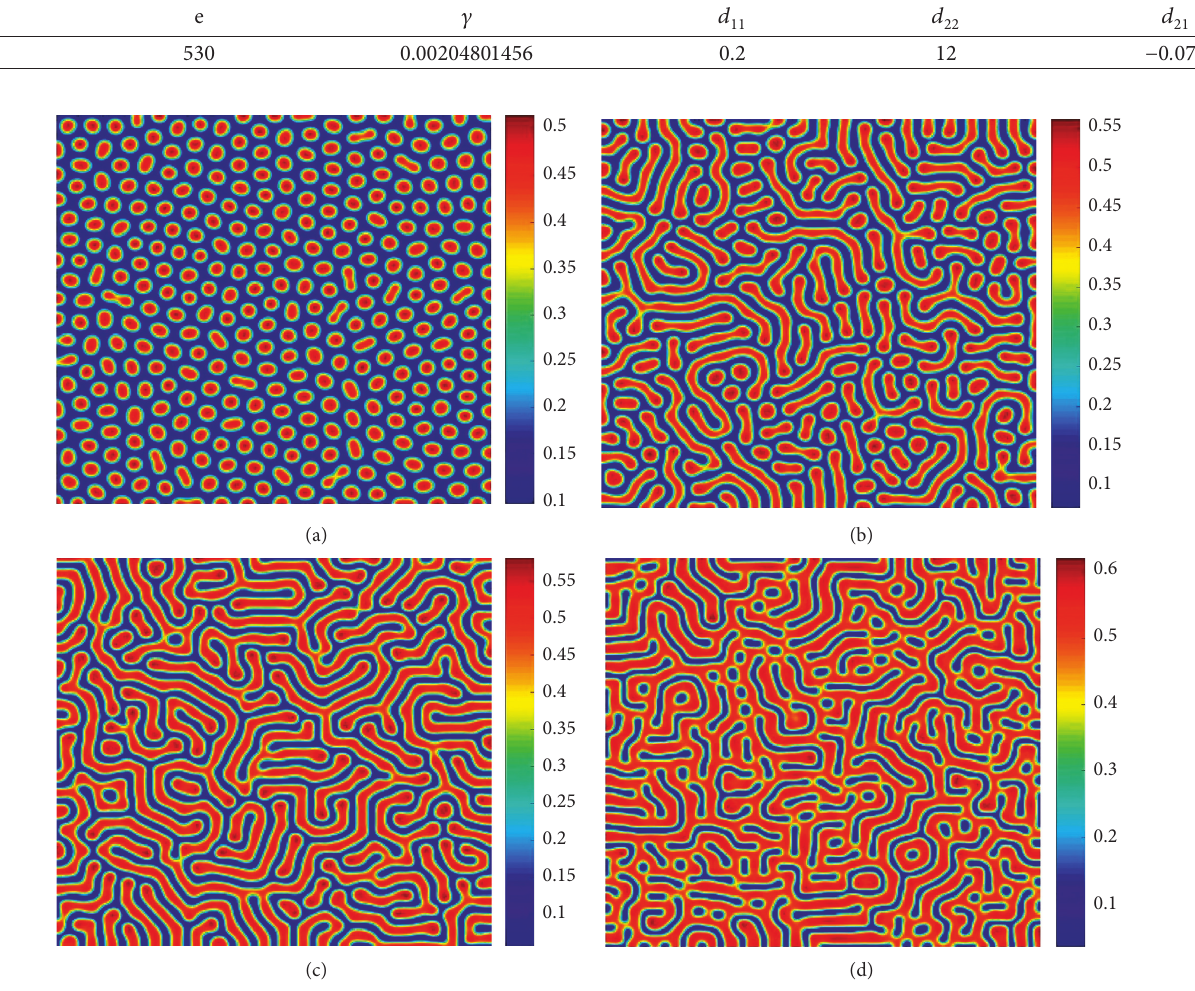
Figure 7: Spatial patterns of prey induced by cross-diffusion. (a) d